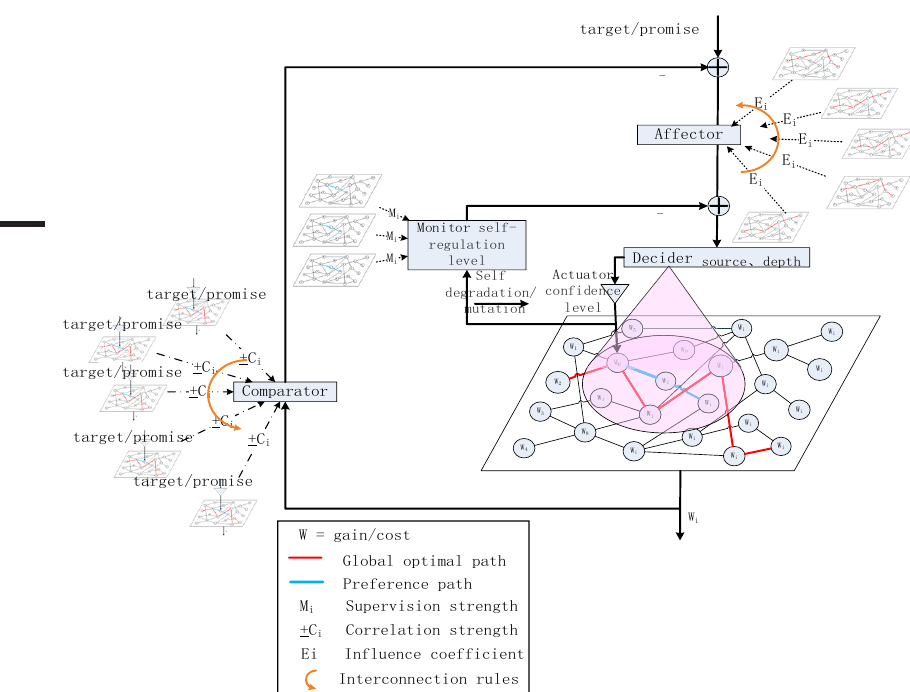
Figure 1. Primitive